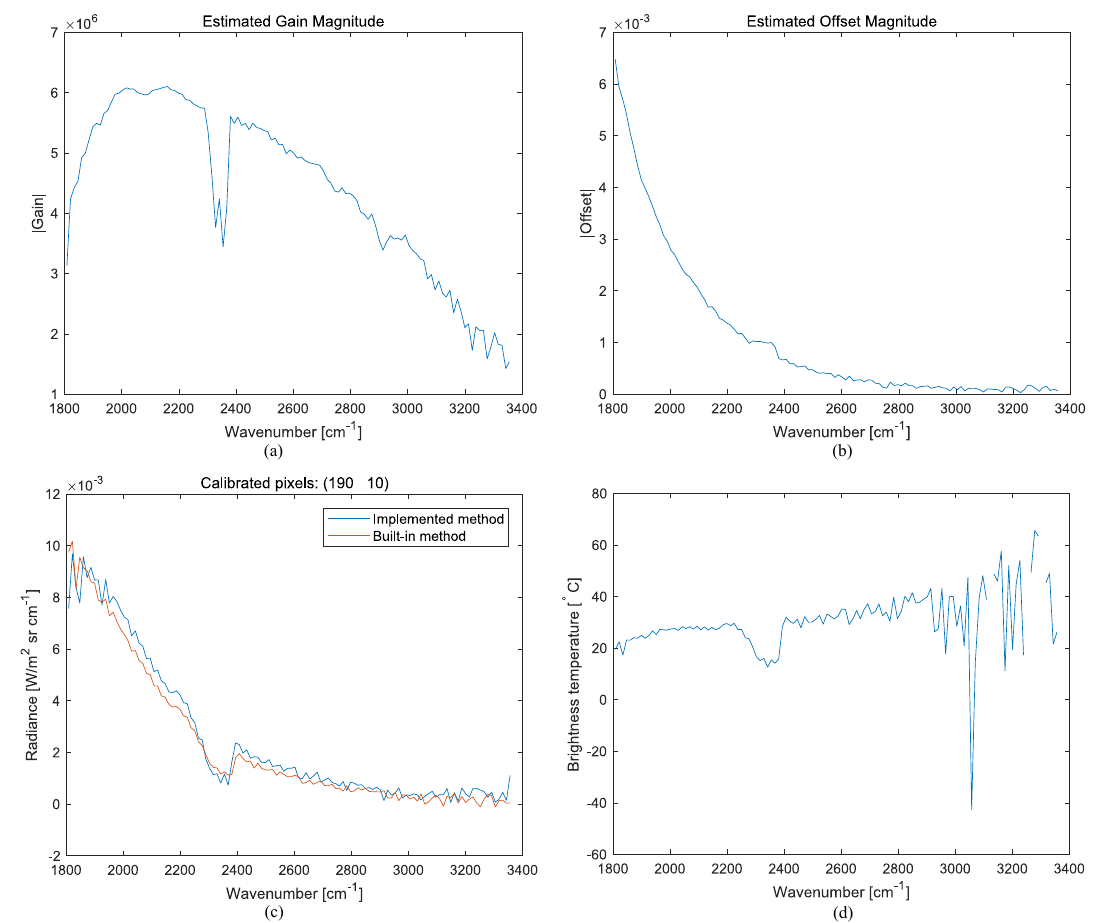
Figure 5. Radiometric calibration and brightness temperature extraction: ( a ) estimated gain magnitude; ( b ) estimated offset magnitude; ( c ) comparison of the radiometric calibration between the implemented method and built-in method; ( d ) calculated brightness